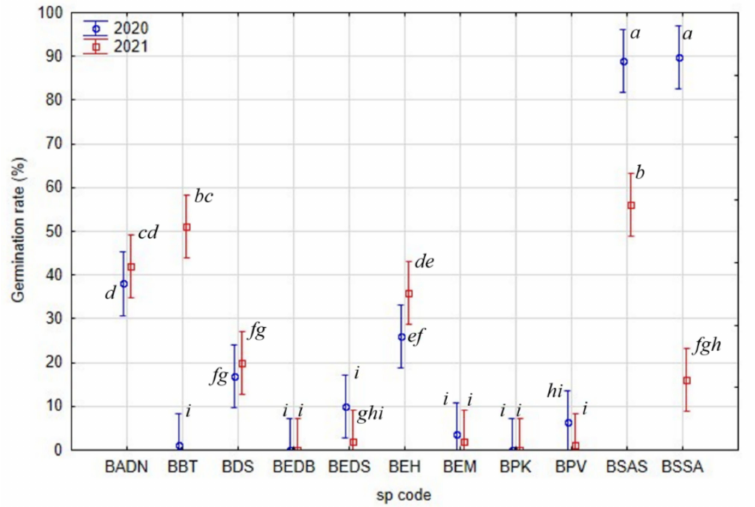
Figure 6. Inter-annual variability of seed germination rate of tested Boswellia species (a, b, c, d, e, f, g, h, i—Indexes denoting localities with significantly separate germination rates within individual taxon, the same index associates the seed without statistically significant difference in germination